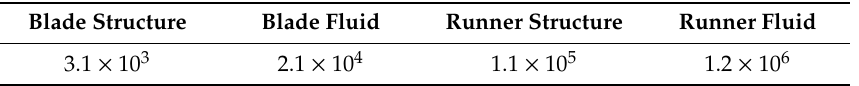
Table 2. Number of elements of the various meshes for the structure and fluid domains.